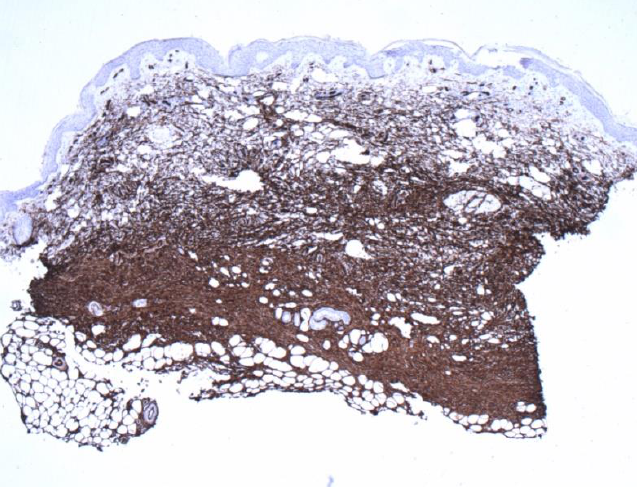
Figure 4. Positive CD34 staining with contrasting sparse-superficial and dense-deeper areas (4×).